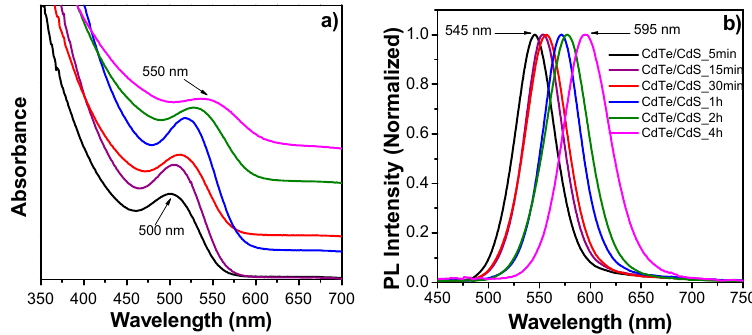
Figure 6. ( a ) UV–vis absorption; ( b ) PL spectra of the CdTe/CdS 1:1 core/shell growth with a Cd 2+ :thiourea (S 2 − ) molar ratio of 1:1.